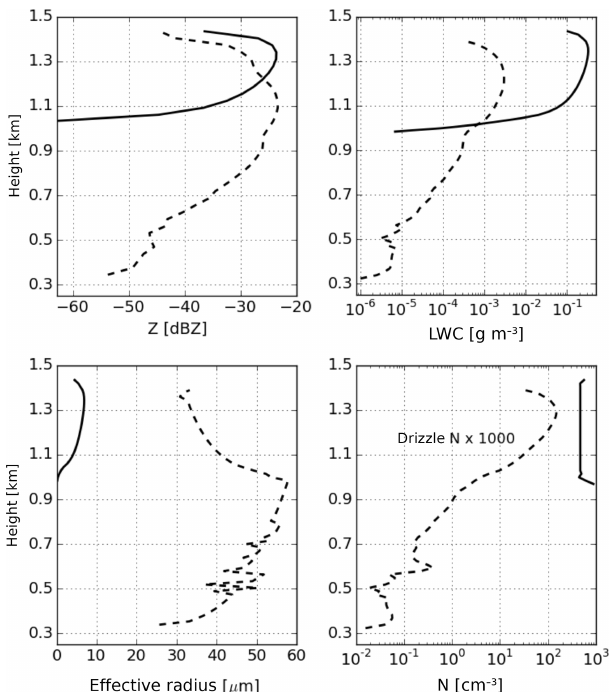
Figure 9. Mean vertical profiles of the cloud (solid lines) and driz- zle (dashed lines) properties from the observation on 26 October 2014 between 3.8 and 4.0UTC. Clockwise from the top left: radar reflectivity factor in dBZ, liquid water content in gm − 3 , number density per cm 3 and effective radius in µm. Note that the number density of the drizzle has been multiplied by a factor of 1000 for illustration